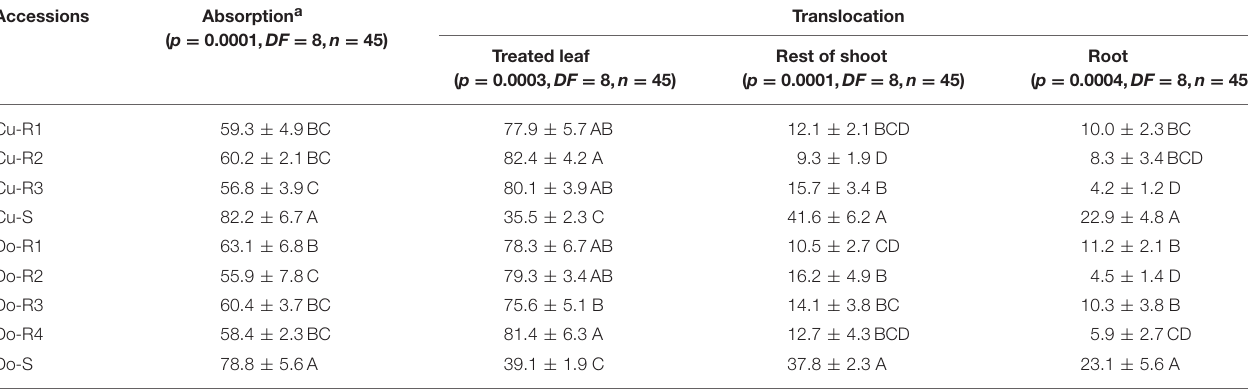
TABLE 3 | 14 C-glyphosate absorption (% of recovered radioactivity) and translocation (% of absorbed radioactivity) in the different P. hysterophorus accessions at 96h after treatment (HAT).